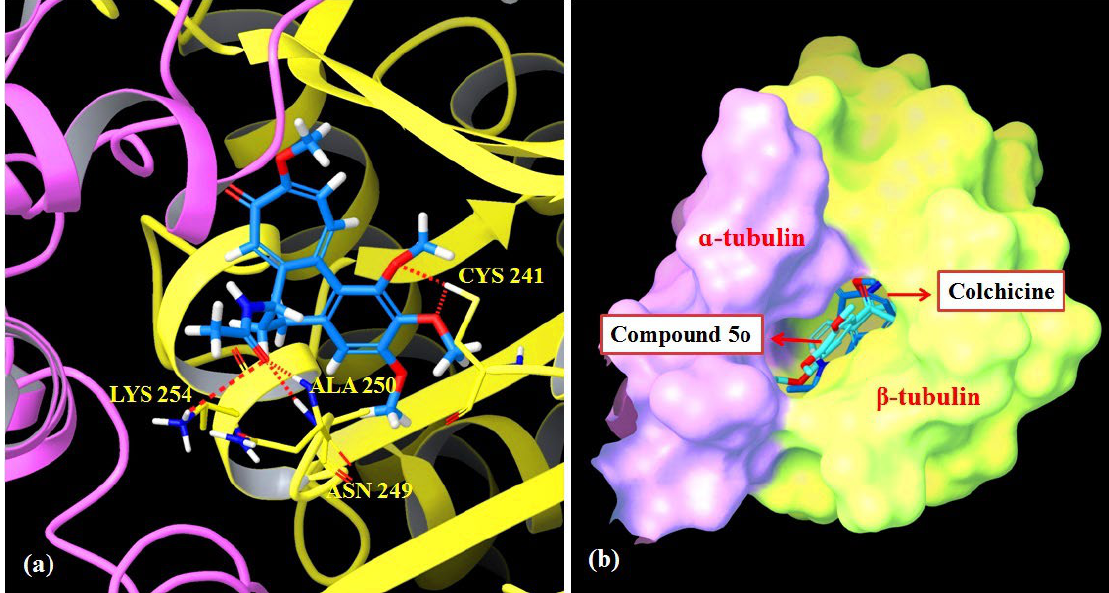
Figure 5. ( a ) Docked pose of colchicine (blue color) showing hydrogen bond interaction (red dashed lines) with ASN 249, ALA 250, LYS 254, and CYS 241 in the colchicine-binding site of tubulin. The α -chain is represented in a purple color cartoon and the β -chain is represented in a yellow color cartoon model. ( b ) Receptor surface of superimposing docked pose of compound 5o (turquoise-color stick model) with colchicine (blue-color stick model) at colchicine-binding site of tubulin. The α -chain is represented in the purple color surface and the β -chain is represented in the yellow color surface.